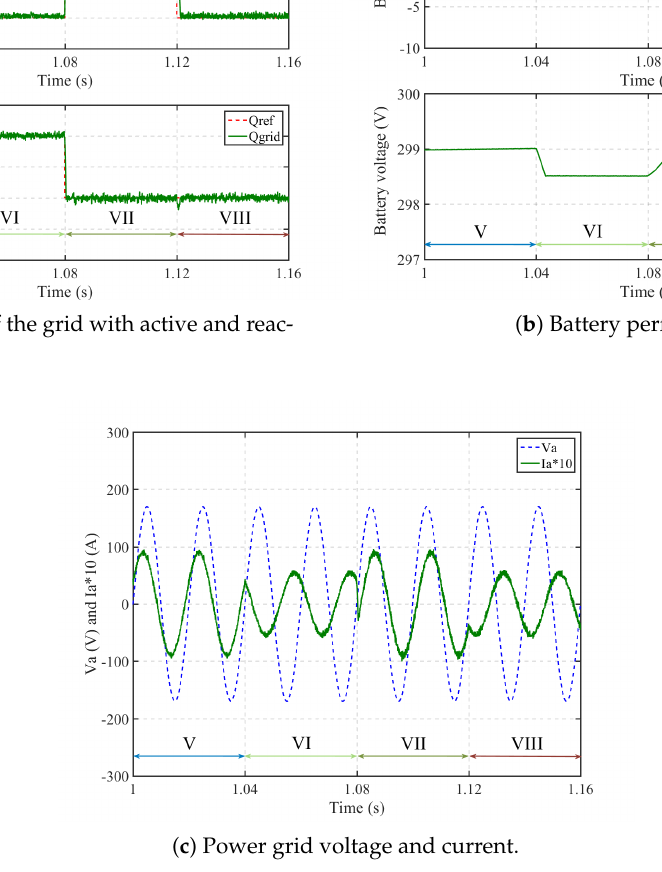
Figure 9. Simulation results in Quadrants V, VI, VII, and